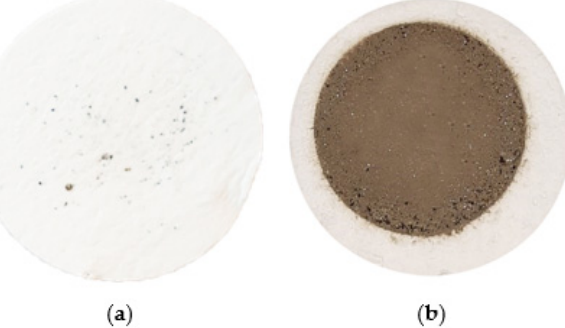
Figure 6. ( a ) Filter after filtering 50 mL of a visually clean sample; ( b ) Filter after filtering 50 mL of sample P4—a ‘ring’ of large particles is evident.